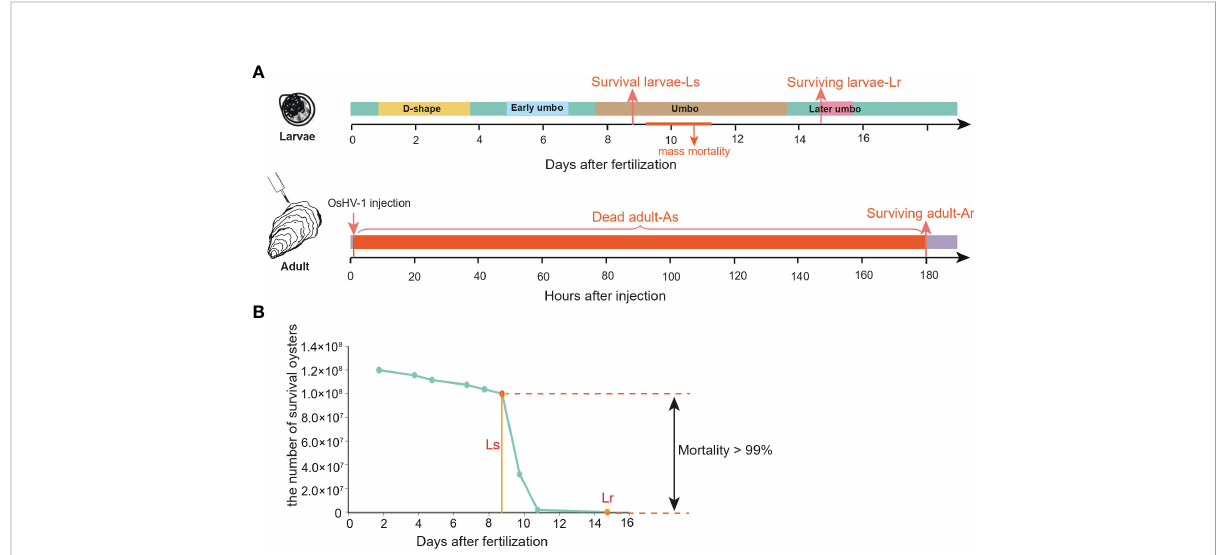
FIGURE 1 The Paci fi c oyster response to OsHV-1 m Var infection in both larvae and adults. (A) schematic diagram of experimental design. Ls, larval susceptible population; Lr, larval resistant population; As, adult susceptible population; Ar, adult resistant population. (B) cumulative survival of oyster larvae (survival number) and mortality rates of pooled sequenced populations in